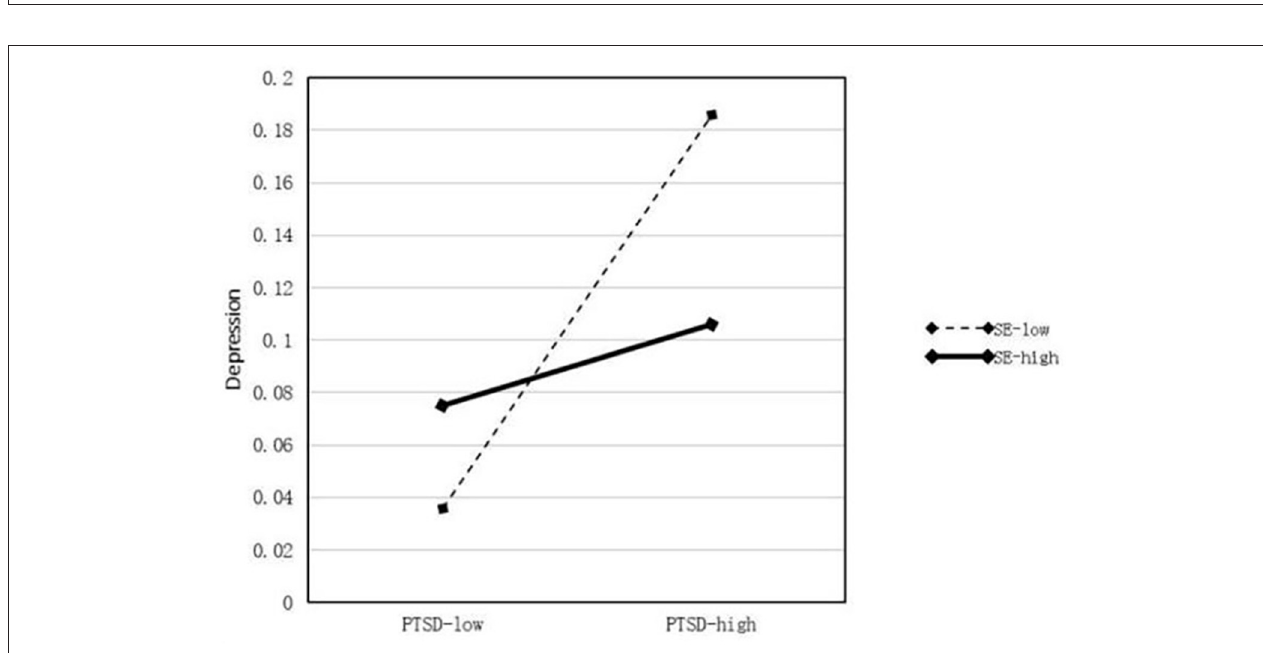
FIGURE 2 | Moderating role of self-efficacy in the effect of PTSD on anxiety.